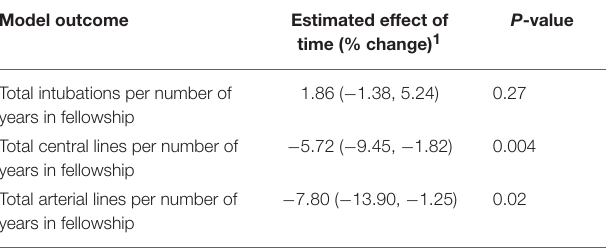
TABLE 2 | Poisson Regression Model